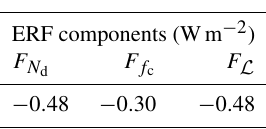
Table A2. ERF aci components calculated by PRP on f c and in-cloud N d and q l